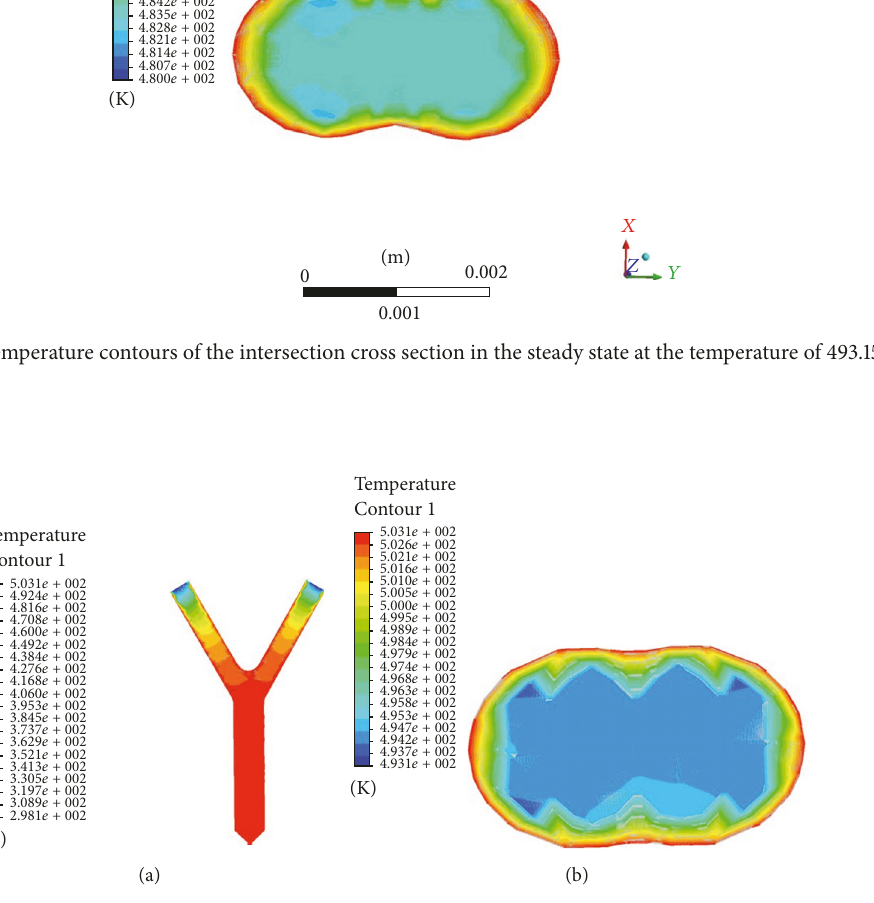
Figure 8: The temperature distribution in the steady state at the time of 50 s: (a) the temperature distribution of flow channel; (b) the temperature distribution of the cross section of the